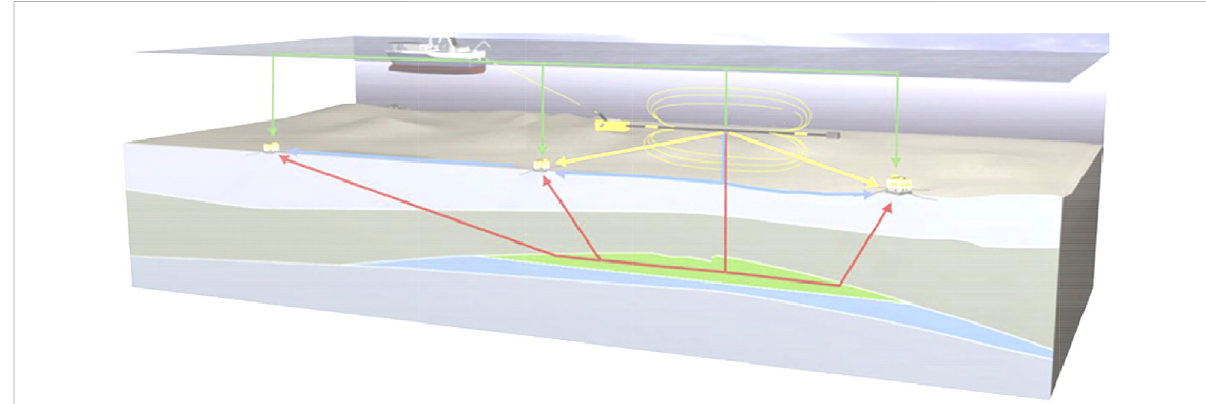
FIGURE 1 Con fi guration of the marine CSEM exploration system with deep near-sea fl oor towed horizontal electric dipole (HED) transmitter and multiple ocean bottom receiver array arrangements along the survey line. The two-dimensional survey grid is composed of multiple survey lines that can carry out 3D exploration The ship towed a long cable with the HED transmitter close to the sea fl oor to enhance the weak response signal from beneath the sea fl oor. The low-frequency electromagnetic wave with a controllable waveform is transmitted by the transmitter. The wave propagates to the surrounding areas, including 1) penetrating the submarine stratum and HC that was received by the receiver (red line), 2) propagation in seawater that was received by the receiver (yellow line), 3) propagation through the sea fl oor (blue line), 4) propagation through the sea surface (green line). If the receiver can measure the obvious electromagnetic response signal from HC, it can help us detect the distribution structure of